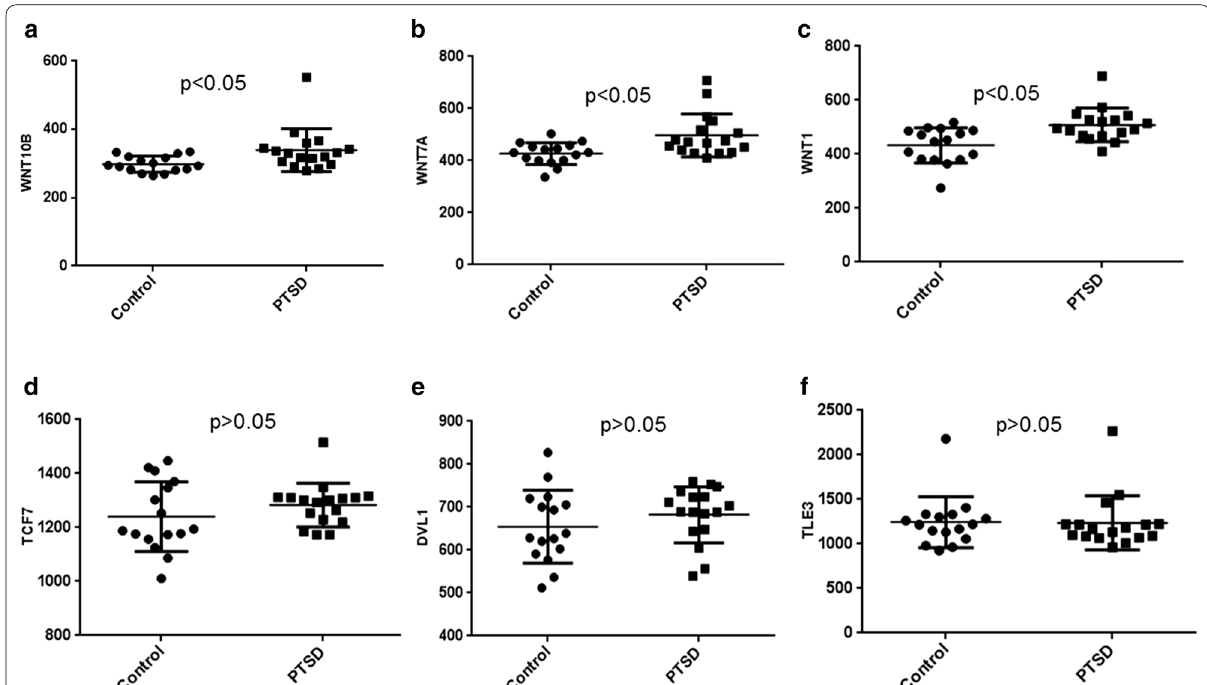
Fig. 5 WNT pathway gene expression analysis from GEO Dataset. We compared the expression levels of WNT pathway genes in a GEO dataset (GSE860, Dataset 2), with data obtained from PBMCs of PTSD and controls by microarray, to confirm the observations in our dataset obtained from samples we collected. a – f WNT pathway genes expression levels in Dataset 2. a – c corresponds to different WNT ligands upregulated in PTSD. One symbol represents an individual. The expression level corresponds to the values obtained from the analysis performed on GEO2R in the GEO dataset link. The p values were obtained by performing Student’s t test on the values obtained from the